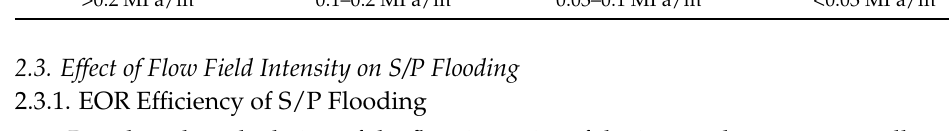
Table 3. The scheme of the displacement efficiency